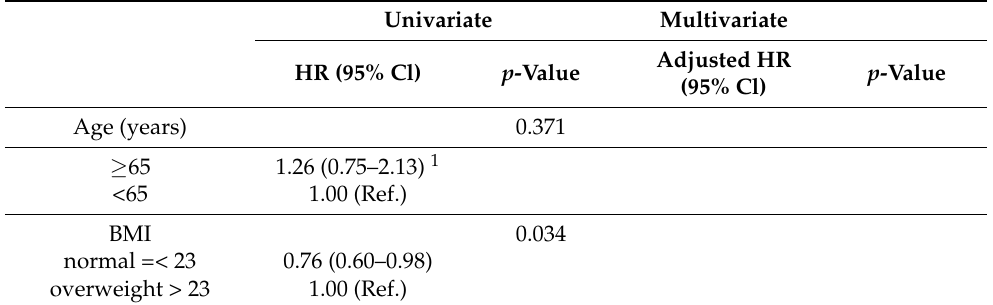
Table 2. Univariate and multivariate analysis of prognostic factors for the progression-free survival (n =